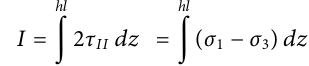
FIGURE 3 | Schematic example of integrated stress evolution through time and amount of convergence expressed as bulk shortening (BS) for an experiment where subduction initiates at the passive margin. The steep increase in the early stage represents elastic loading. The stress values presented in Figure 4 are stresses integrated over the whole lithosphere for the three locations indicated by the coloured arrows in Figure 2A (model boundary Ib , passive margin Ipm , oceanic basin Io ). t0 and ts refers to the timeatthestartofthemodelandthetimeofsubductioninitiation,respectively.